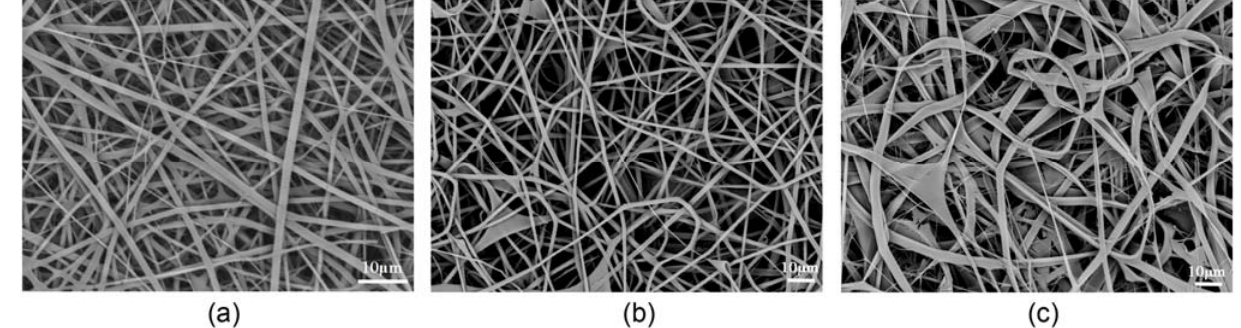
Figure 1. Scanning electron microscope (SEM) images of the nanofibers ( a ) regenerated silk fibroin nanofibers; ( b ) silk/tetramethoxysilane TMOS hybrid nanofibers with TMOS concentration of 5 wt %; and ( c ) silk/TMOS hybrid nanofibers with TMOS concentration of 15 wt